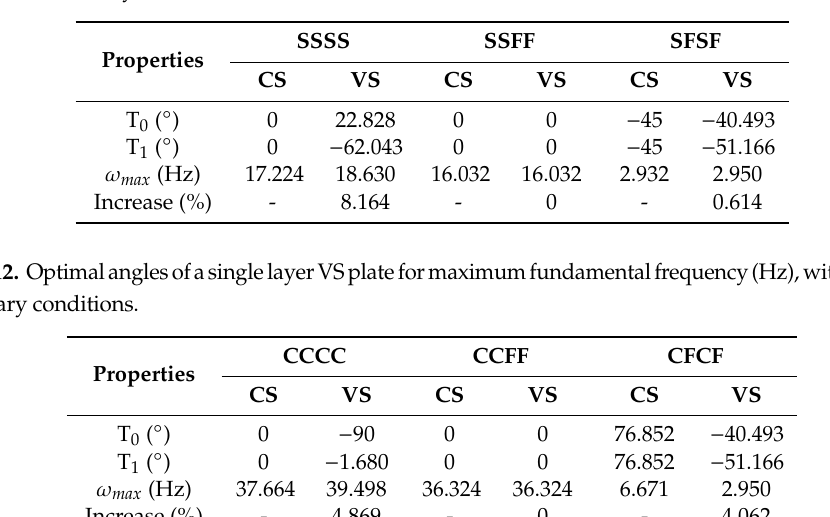
Table 11. Optimal angles of a single layer VS plate for maximum fundamental frequency (Hz), with simply supported boundary conditions.